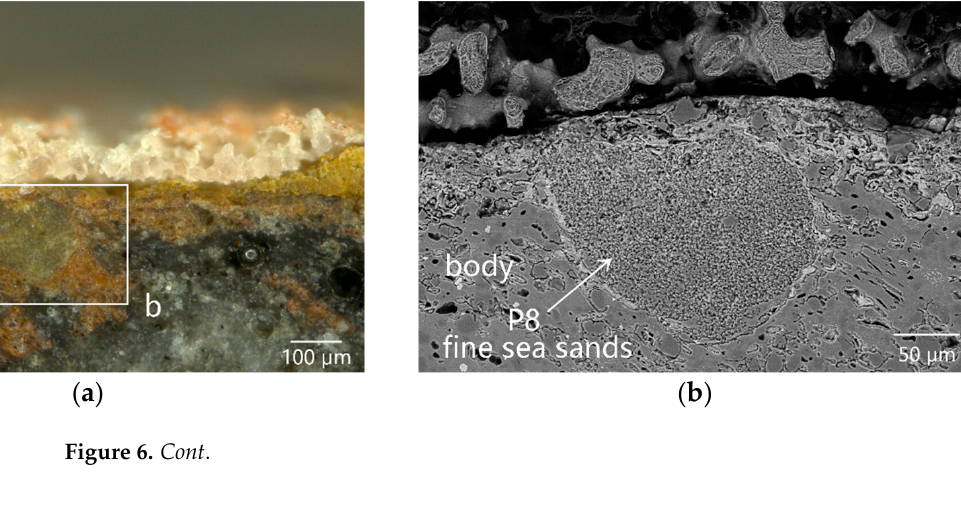
to the surface of the inner surface of the body, ( c ) SEM image of the enlarged image of the region in